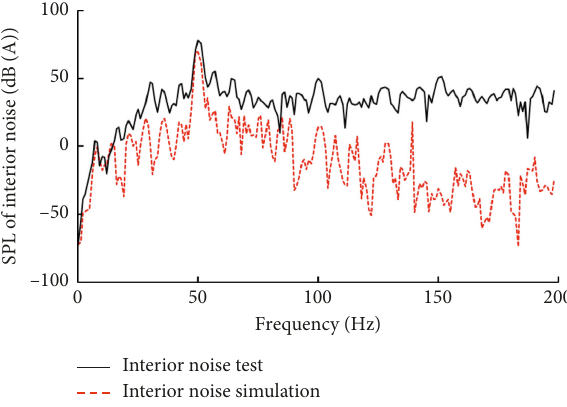
Figure 27: Comparison of simulation and test results.